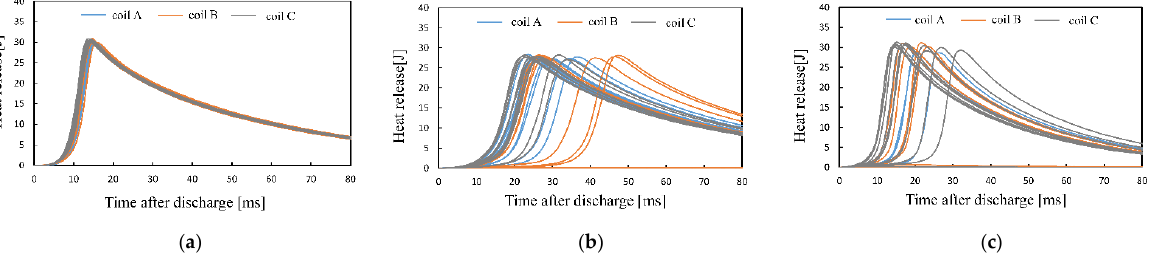
Figure 9. Heat release under different conditions: ( a ) Basic condition; ( b ) High diluted condition; ( c ) High flow condition.